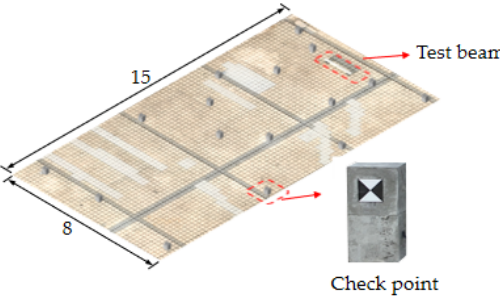
7 of 14 Figure 5. Schematic diagram of testing parameters. 3.2.2. Arrangement of Reference Points Reference points include control points on the side surface of the monitored beam